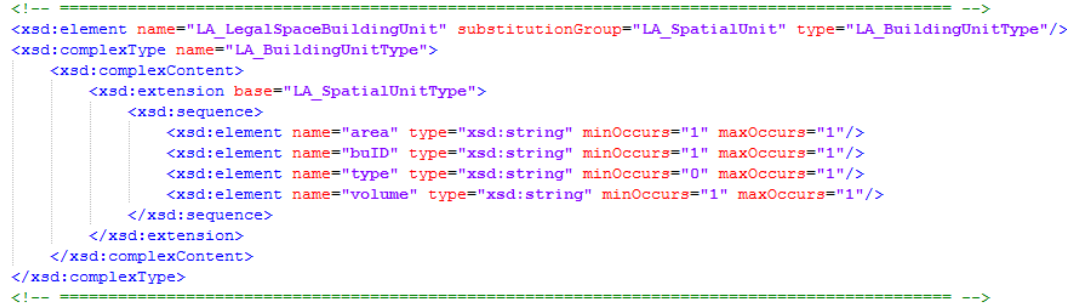
Figure 10. Definition of LA_LegalSpaceBuildingUnit within the XSD file.